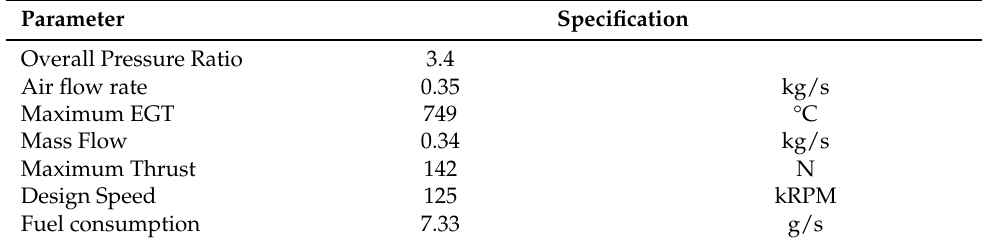
Table 1. Jetcat P140 Rxi-B engine specifications